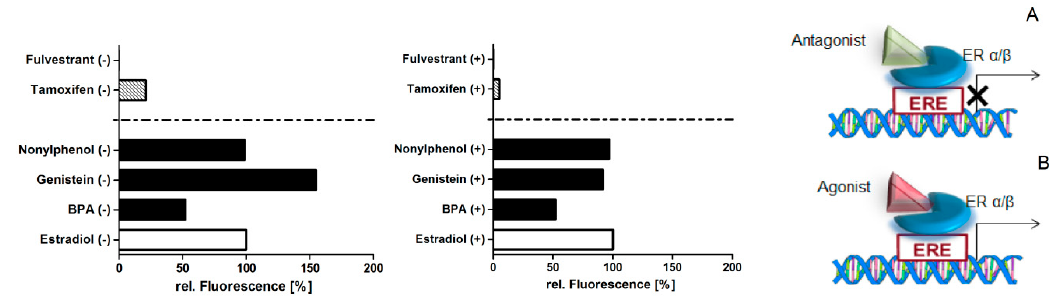
Figure 4. Proliferative effect of MCF-7 cells after treatment with the agonists estradiol, bisphenol A (BPA), genistein, and nonylphenol as well as the antagonists tamoxifen and fulvestrant of the estrogen receptor—left graph without ( − ) and right graph with IL-1ß stimulation (+). The binding of agonists ( B ) to the estrogen receptor results in the proliferation of cells, while the antagonistic ( A ) action inhibits the proliferation. Data ( n = 6) are baseline-corrected to the estradiol treatment and the medium control, and plotted as relative fluorescence. Table 2. Color-coded biomarker secretion patterns. MCF-7 cells (stimulated: +, non-stimulated: -) challenged with tamoxifen, fulvestrant, estradiol, genistein, bisphenol A, and nonylphenol, and marker expression quantified with the chip relative to untreated cells (%). Colors are graded in steps of 20%.